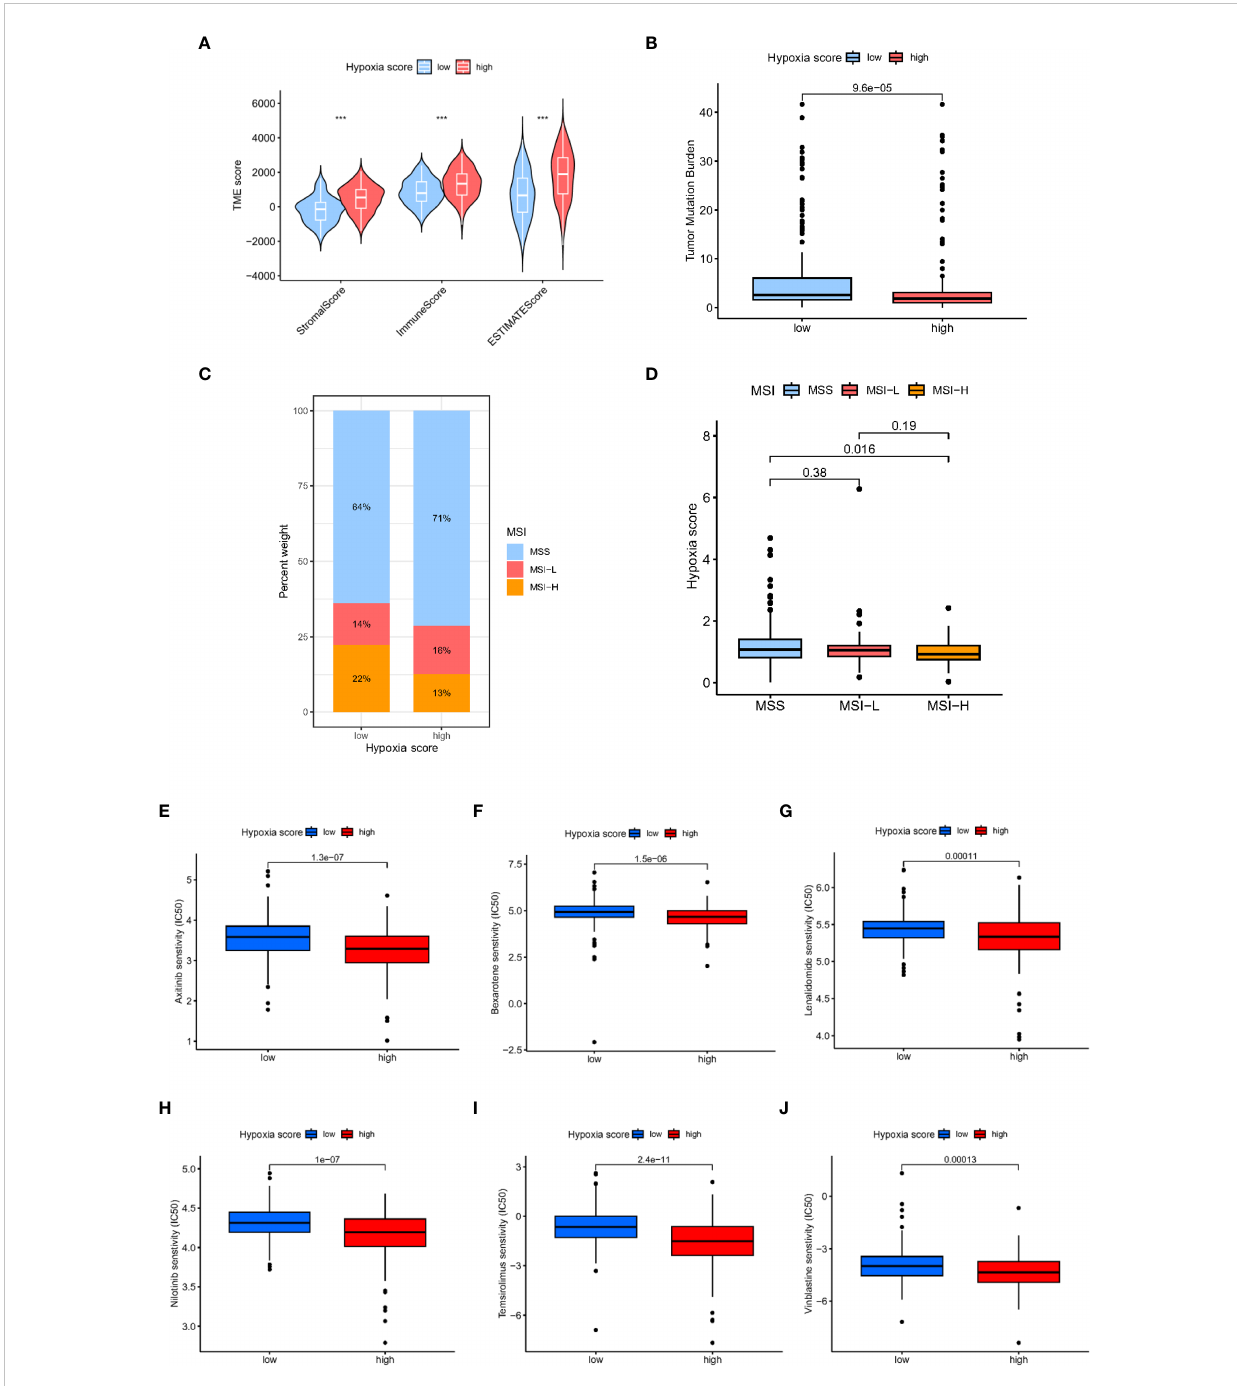
FIGURE 7 Analysis of tumour microenvironment and drug sensitivity in patients with different hypoxia scores. (A) TME scores in patients with different hypoxia scores based on ESTIMATE. (B) The TMB in different hypoxia score groups. (C, D) Relationship between hypoxia score and MSI. (E) Relationship between hypoxia score and tumour stemness index. (E – J) : Sensitivity analysis of hypoxia scores and antineoplastic